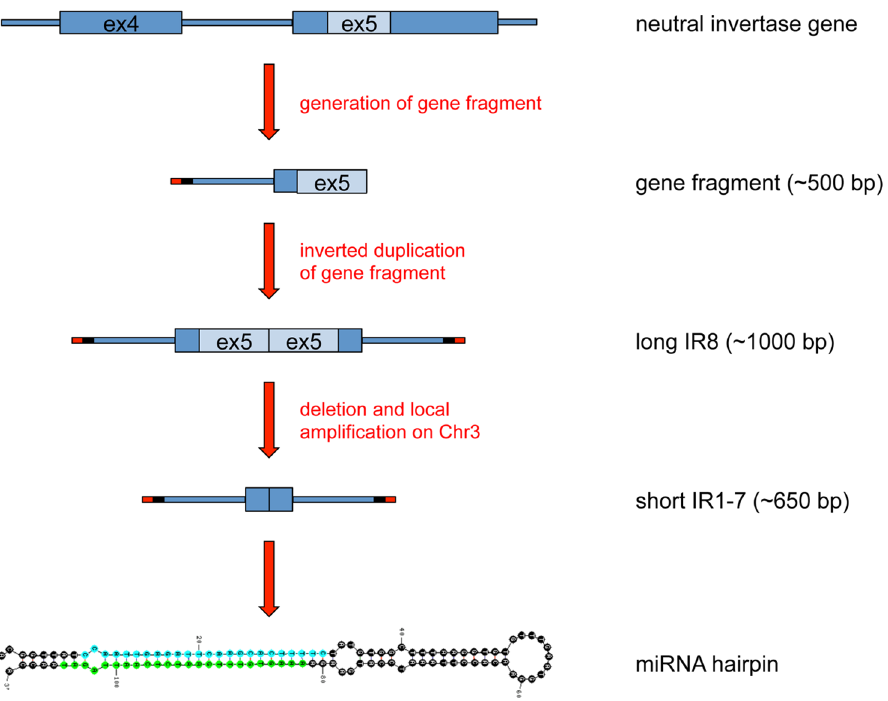
Figure 6. Model Depicting the Evolution of the Soy-miR15/49 Family from an Inverted Duplication of a Neutral Invertase Gene Fragment. A neutral invertase gene fragment containing parts of its intron 4 (blue line) and exon 5 (blue and light blue rectangle) was linked to a short LTR terminal fragment (red line) and a short sequence of unknown origin (black line). This complex DNA arrangement underwent an inverted duplication event, which resulted in a long inverted repeat fragment (IR). Subsequently, this long IR was amplified and transposed to different chromosomes. One copy on chromosome 3 experienced a deletion of a short inverted sequence (light blue rectangles) at its center region, thereby generating a shortened IR structure. This shortened IR went through a series of local amplification events to produce IR1-7, which further evolved to the soy-miR15/49 family. The hairpin structure of MIR15a and its miRNA and miRNA* are shown at the bottom.